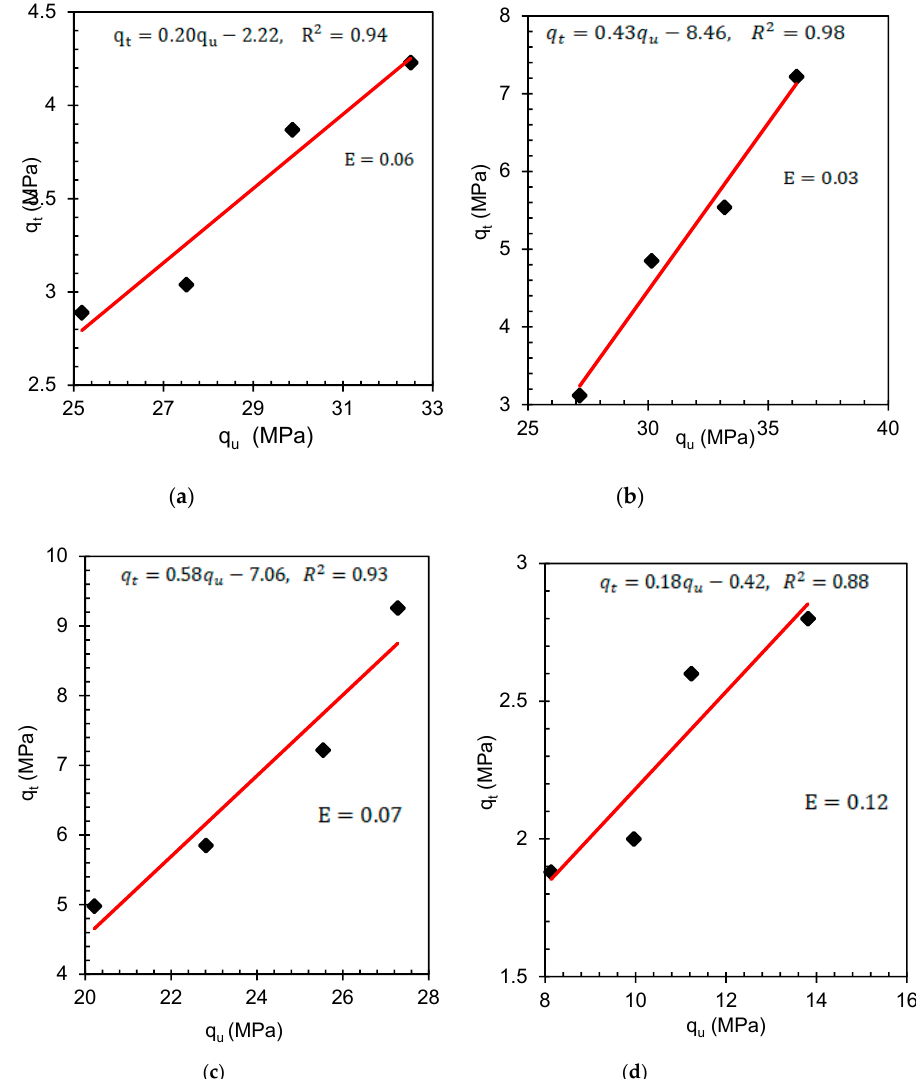
Figure 8. ( a – d ) Interdependence of q t and q u of PWB-1, PWB-2, PWB-3 and clay bricks brick composites for strength